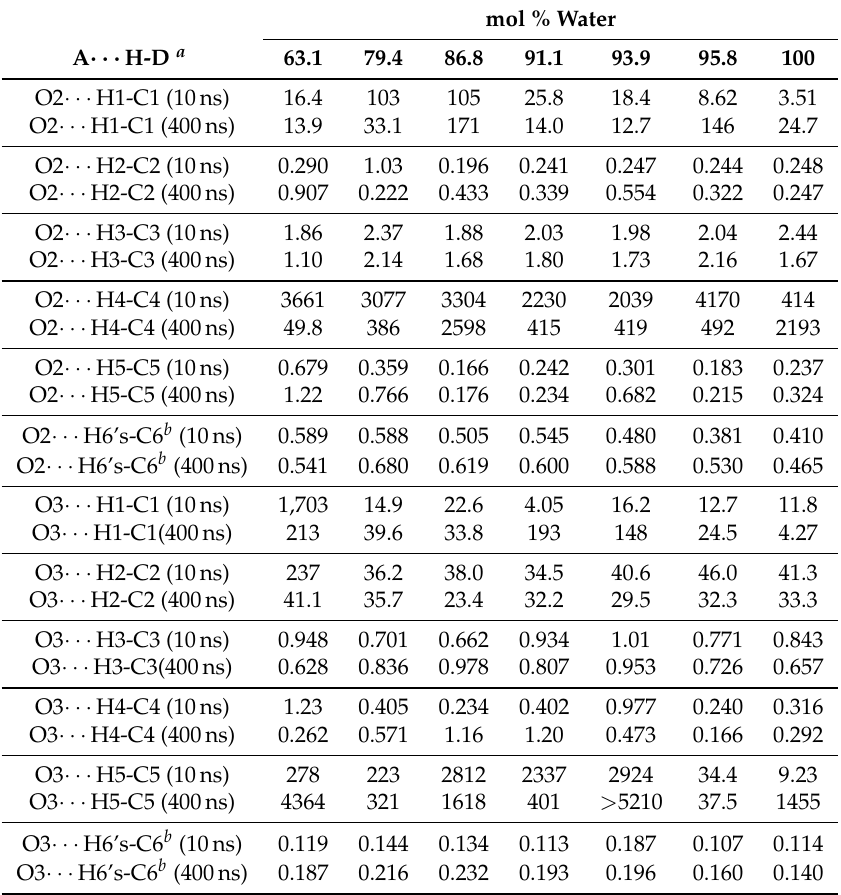
Table A2. TBPCl hydrogen bonding lifetimes (ps), Part 3 of 5.